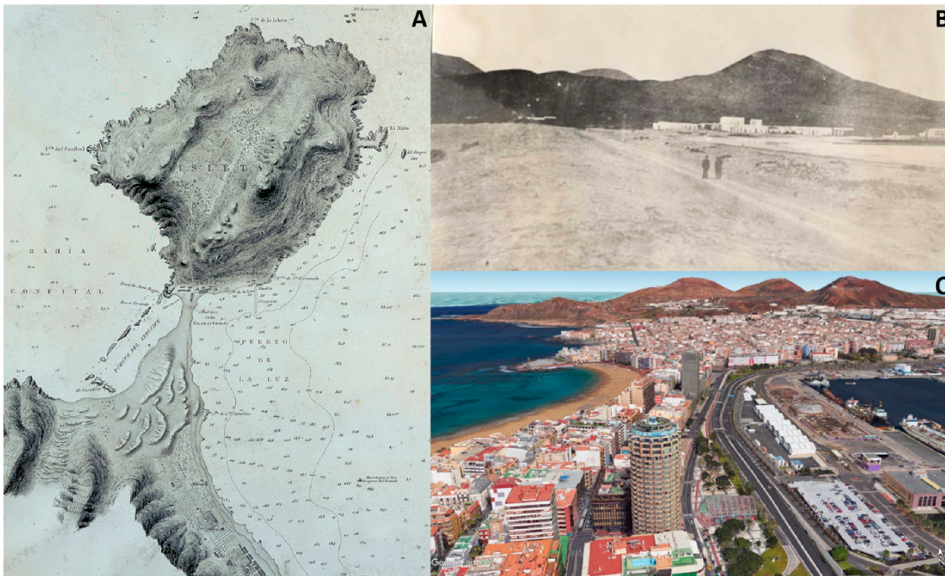
Figure 4. ( A ) Nautical chart of 1879 of the area of Guanarteme and La Isleta in Gran Canaria Island showing the sandy dune formations along the isthmus (source: https://commons.wikimedia.org/wiki/File:Isleta-peninsula-Gran-Canaria-Old-Map-1879.jpg, (accessed on 15 March 2021). ( B ) Photo of the sand fields in the 80s (Source: [Luis Ojeda Pérez]. Archivo de fotografía histórica de Canarias. Cabildo de Gran Canaria. Fedac). ( C ) Present day view of the northeastern zone of the city where the sand is restricted to the beach (image from Google Earth).